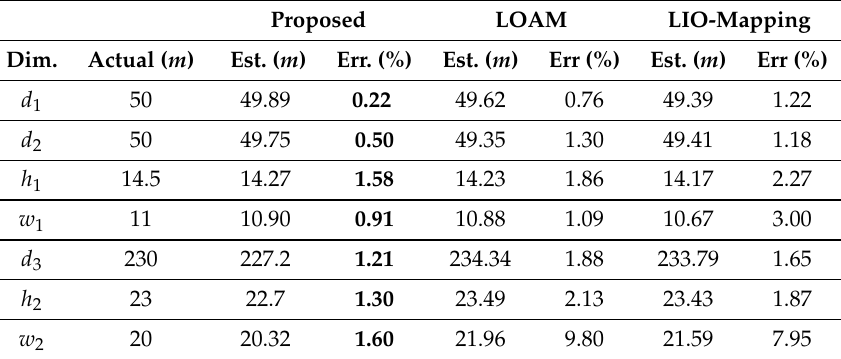
Table 2. Experimental results and comparisons (proposed method vs. LOAM [22] vs. LIO-mapping [36]) for Deungseon Bridge ( d 1 , d 2 , h 1 , and w 1 ) and Geobukseon Bridge ( d 3 , h 2 , and w 2 ). Proposed LOAM LIO-Mapping Dim. Actual ( m ) Est. ( m ) Err. (%) Est. ( m ) Err (%) Est. ( m